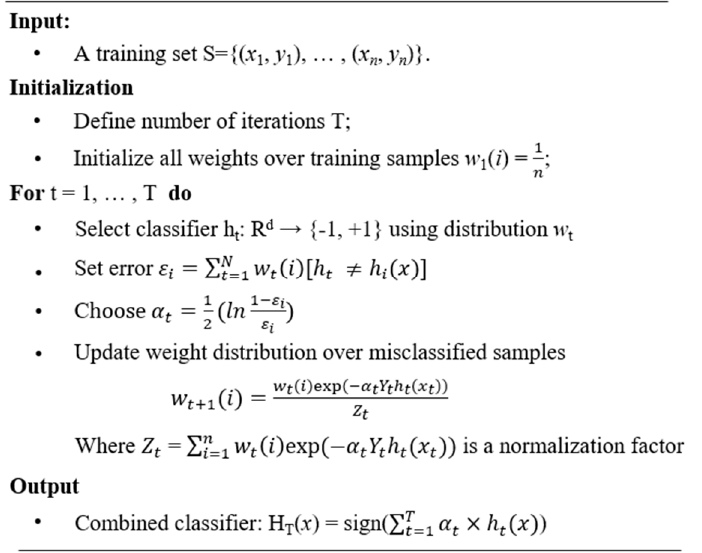
Figure 2. The working principle of AdaBoost classifier.